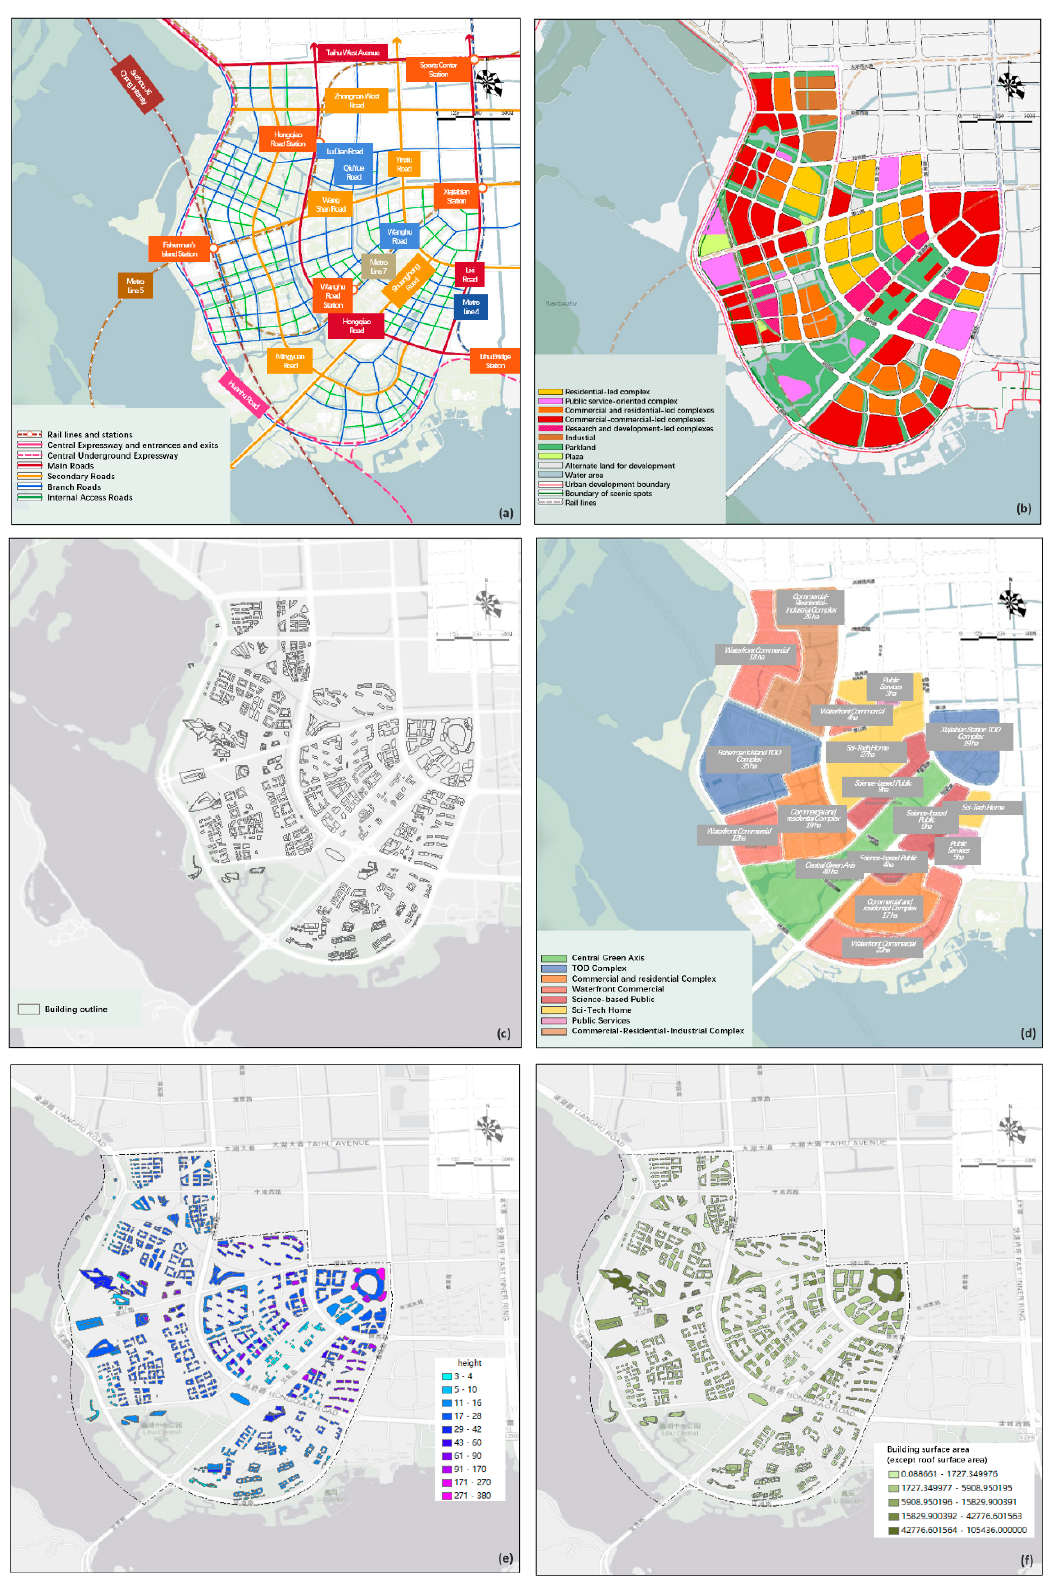
Figure 2. Data preparation: ( a ) road network, ( b ) land use, ( c ) architectural scheme, ( d ) functional zoning, ( e ) building height, ( f ) building surface area (except roof surface area) [24].